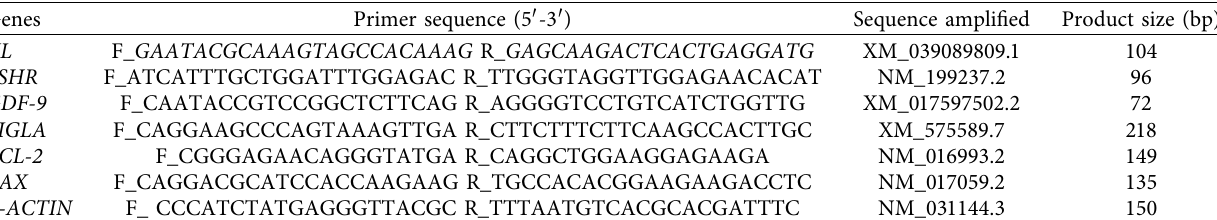
Table 1: Oligonucleotide primers.